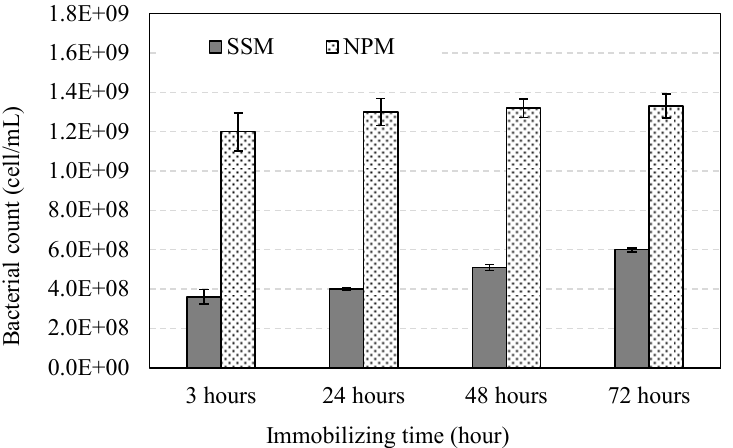
Figure 6. Effect of immobilization techniques on the population of bacteria in expanded vermiculite.